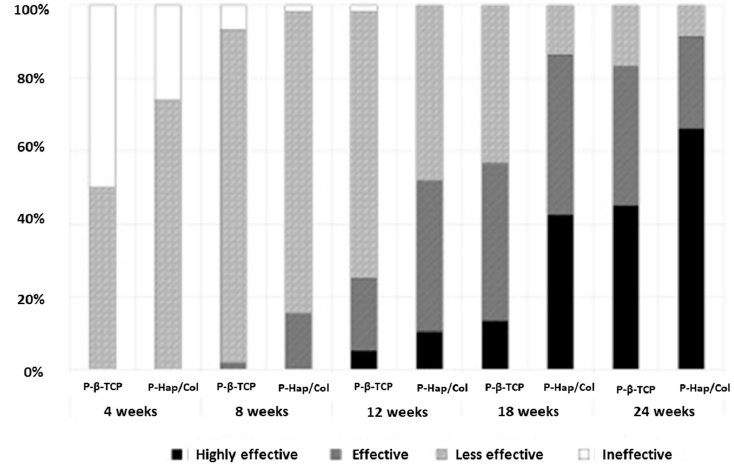
Figure 6. Results of X-ray evaluation. The scores improved over time during the follow-up period in both groups. At each time point, the score in the HAp/Col group was higher than that in the β -TCP group. Reprinted from [74] with permission from